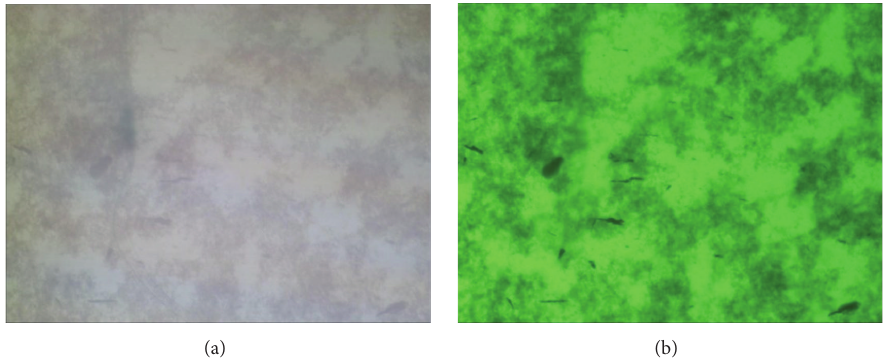
Figure 8: Photos of ferrographic record for sample E: (a) bottom light, (b) upper light.